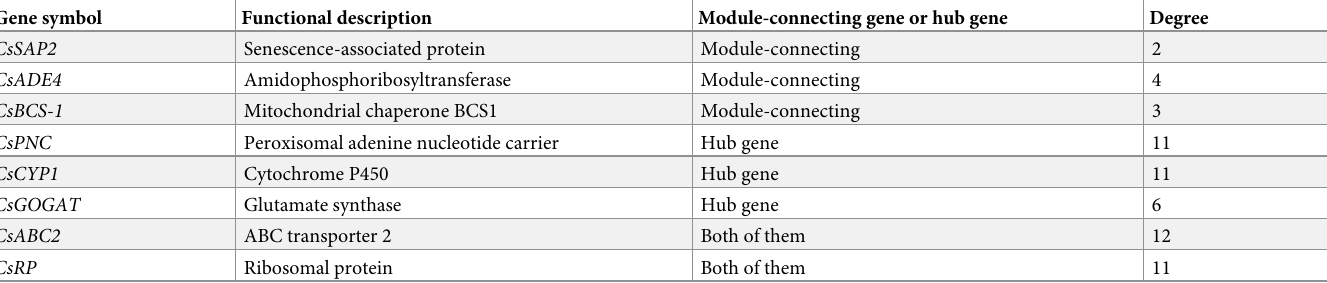
Table 2. Module-connecting genes and typical hub genes in the three gene functional modules. Gene symbol